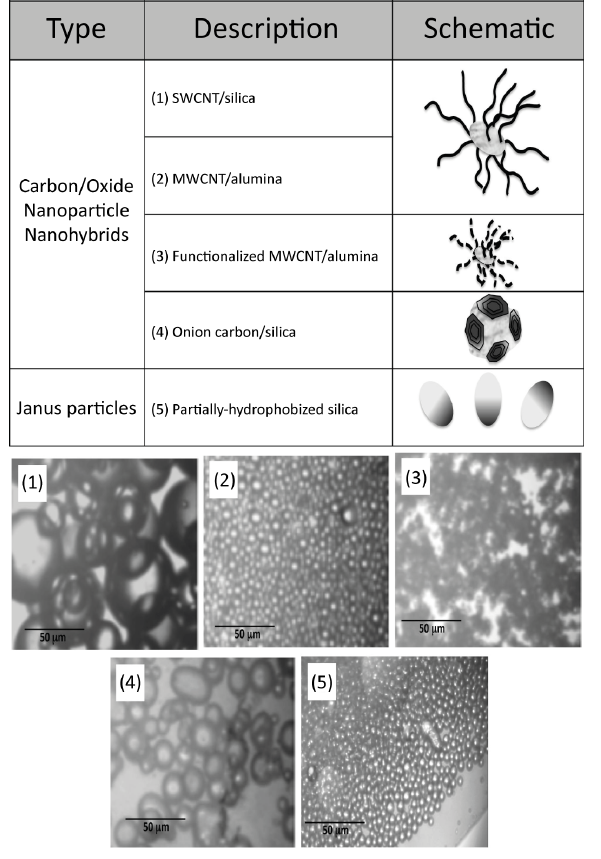
Figure 34. ( top ) Schematic description of different nanohybrids being used as emulsion stabilizers and support of metal clusters; and ( bottom ) optical microscopy images of water/decalin emulsions stabilized by these nanohybrids. Figure reproduced from Ref.